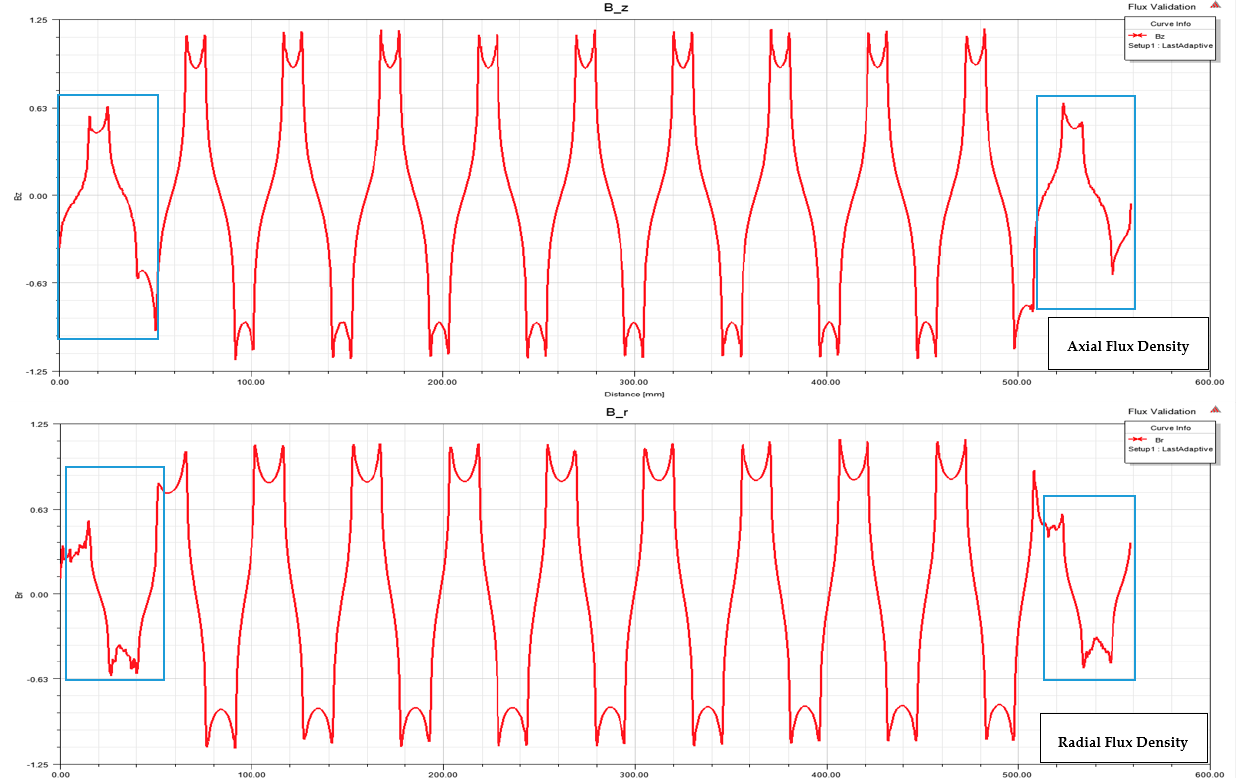
Figure 6. Multiple Poles Magnetic flux plots for the shaft with Segmented Magnetic Arrangement (Ansys electronics desktop).